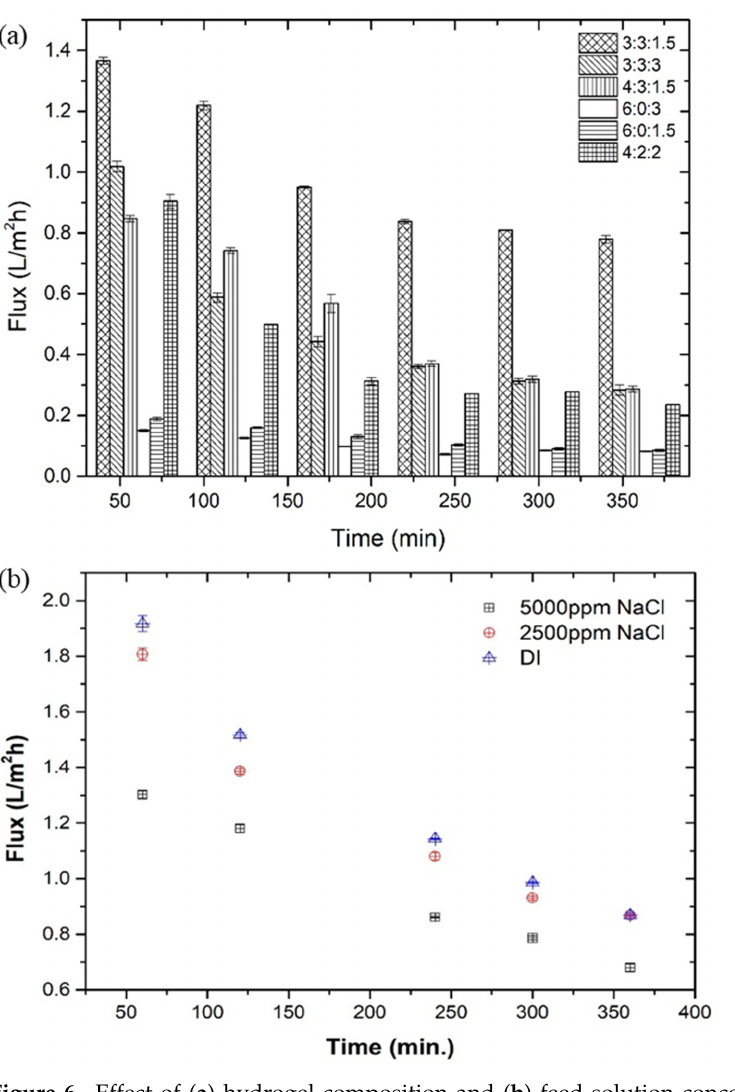
Figure 6. Effect of ( a ) hydrogel composition and ( b ) feed solution concentration on the overall FO performance .